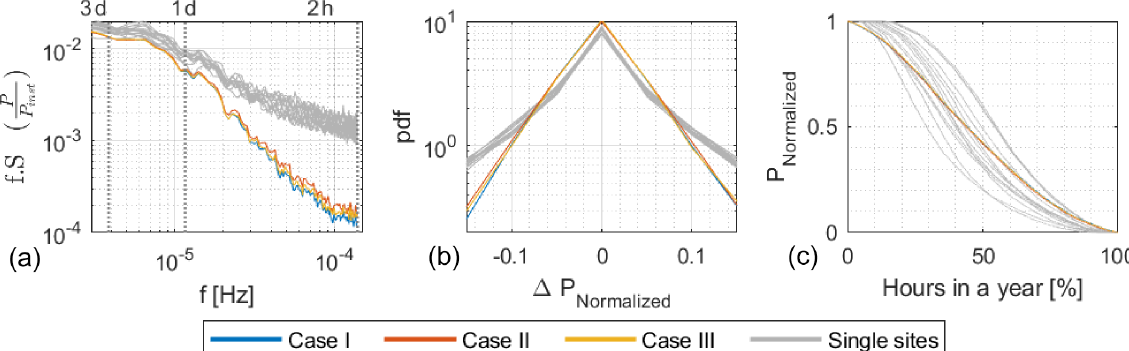
Figure 5. PSD (a) , pdf of hourly step-change functions (b) , and duration curves (c) of lumped hourly wind power output time series per installed capacity ( P ) for the three optimized cases displayed in Fig. 4, as well as for each single turbine output time series P inst